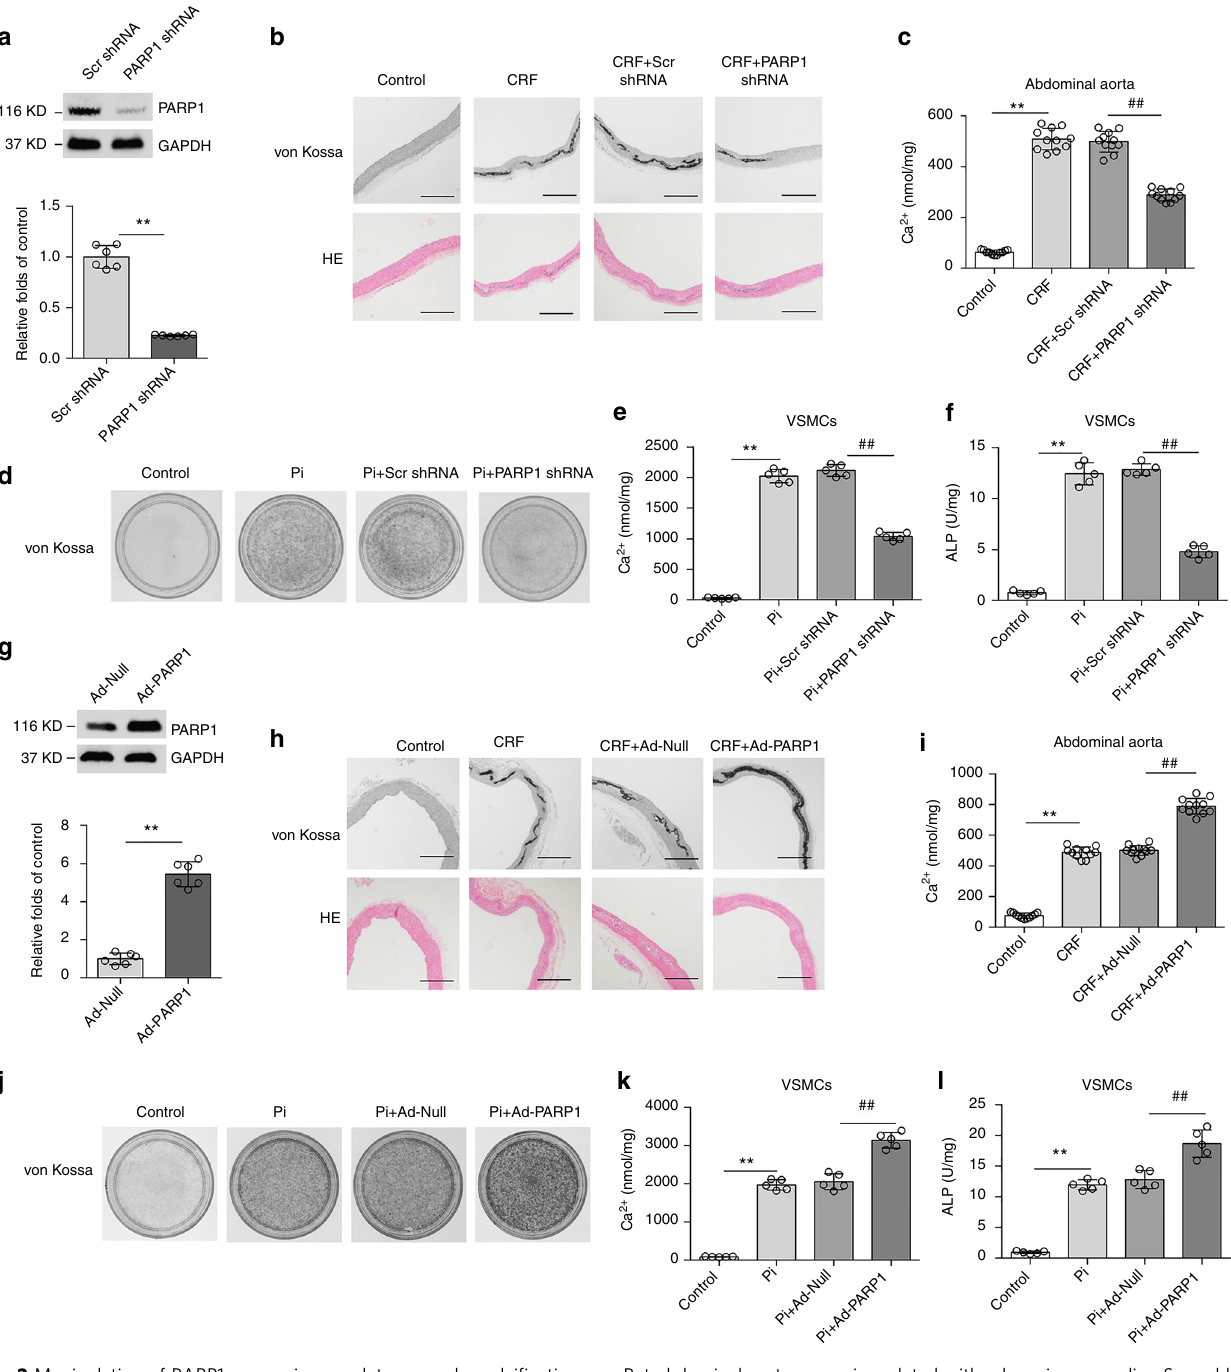
Fig. 2 Manipulation of PARP1 expression regulates vascular calci fi cation. a – c Rat abdominal aortas were inoculated with adenovirus encoding Scrambled (Scr shRNA) or PARP1 shRNA at three weeks after the adenine diet, and then fed for three weeks. PARP1 de fi ciency in arteries was identi fi ed by western blot ( a ) ( n = 5 per group). Aortas were stained by H&E and von Kossa for mineralization ( b ), and the calcium deposition in arteries was quanti fi ed ( c ). ( n = 10 – 12 per group). Scale bar, 100 μ m. d – f Rat primary VSMCs were pre-infected with Scrambled or PARP1 shRNA adenovirus and then exposed to osteogenic medium for 14 days. VSMCs were stained for mineralization by Alizarin red S ( d ), and the quantitative analysis of calcium content ( e ) and ALP ( f ) were detected respectively. ( n = 5 for each group). g – i Rat abdominal aortas were inoculated with Ad-Null or Ad-PARP1 at three weeks after the adenine diet, and then fed for three weeks. PARP1 overexpression in arteries was evaluated via western blot ( g ) ( n = 5 per group). Aortas were stained by von Kossa and H&E for mineral nodules ( h ) and the quanti fi cation of calcium deposition was calculated ( i ). ( n = 10 – 12 per group). Scale bar, 100 μ m. j – l Rat primary VSMCs were pre-infected with Ad-Null or Ad-PARP1 adenovirus and then exposed to osteogenic medium for 14 days. Alizarin red S staining ( j ), calcium content ( k ), and ALP ( l ) in calci fi ed VSMCs were then determined. ( n = 5 per group). Statistical signi fi cance was assessed using one-way ANOVA for multiple comparison and two-tailed t -tests for two groups and is presented as follows: ** P < 0.01 and ## P < 0.01. All values are means ±